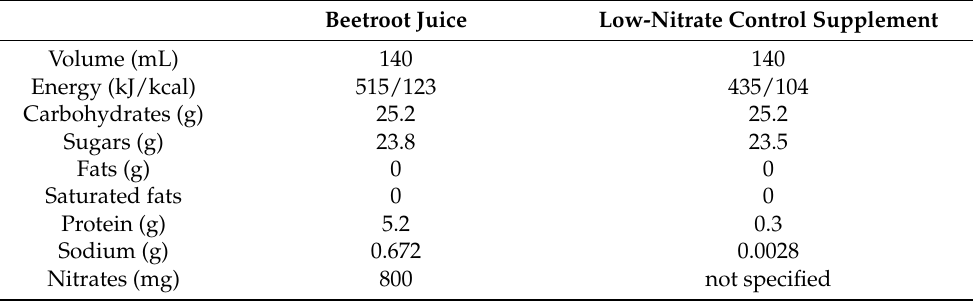
Table 1. Nutritional details of beetroot juice and low-nitrate control